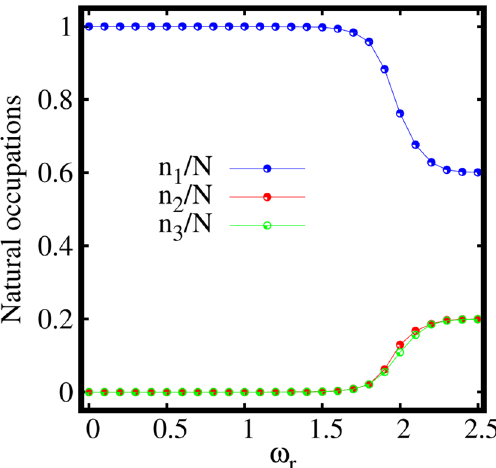
Figure 7. Pathway from condensation to fragmentation in the rotating three-fold symmetric trap. Three- fold fragmentation is observed with increase in rotation. The three leading natural occupations n 1 / N , n 2 / N and n 3 / N , are shown as a function of the rotation frequency ω r . M = 3 self-consistent orbitals are used. All quantities shown are